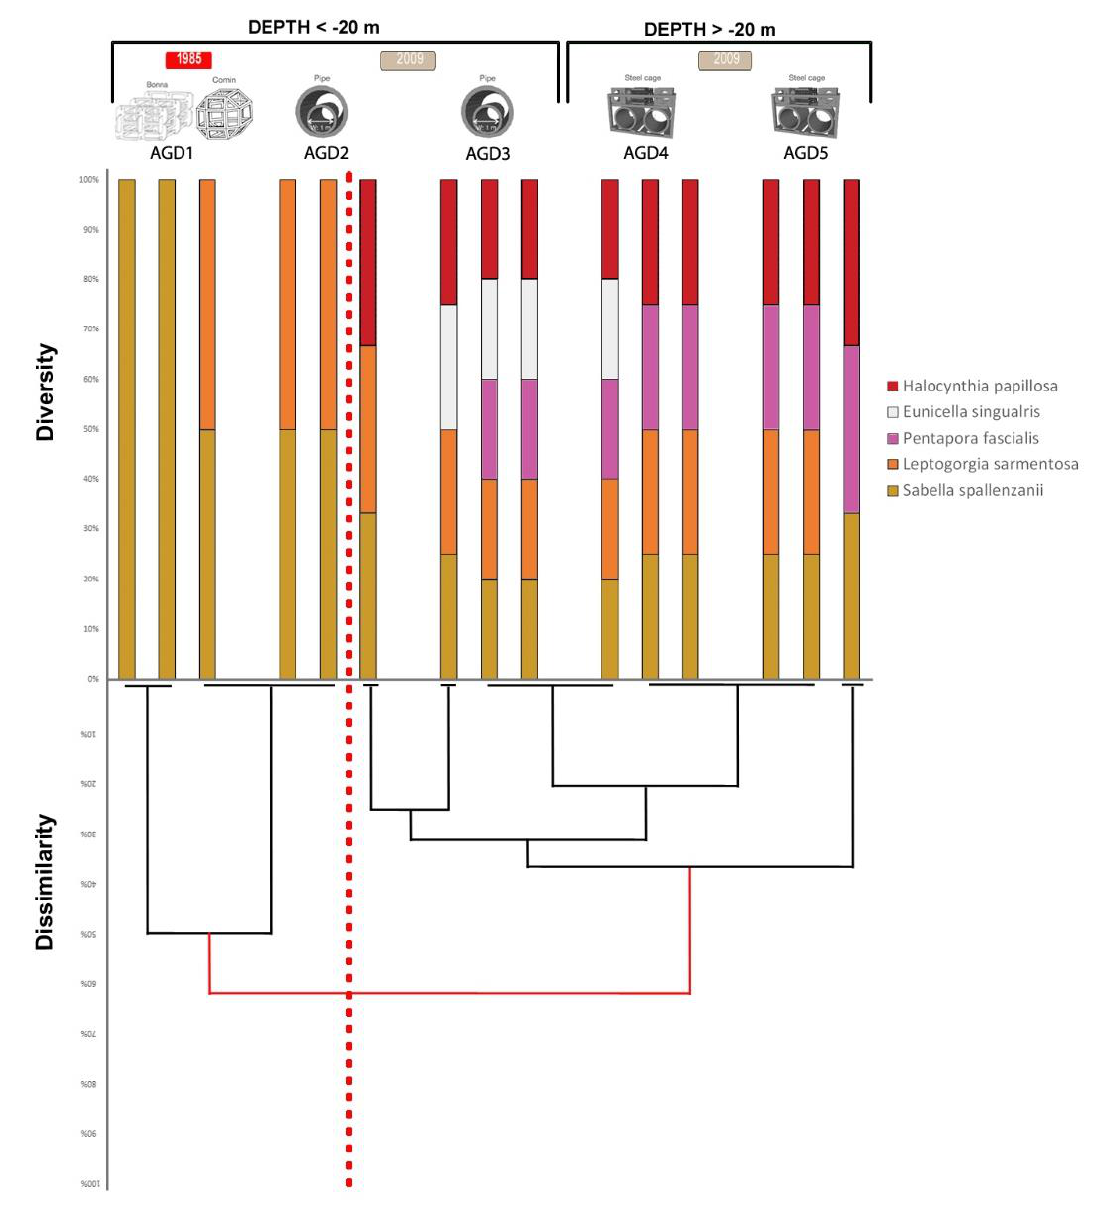
Figure 4: Diversity and dissimilarity. Upper part: diversity of species assemblages in the sampling units of the five sites (AGD1, AGD2, AGD3, AGD4, AGD5) in AGD sector together with the type of AR, depth and years of deployment. Lower part: dendrogram obtained by group average clustering based on the Jaccard dissimilarity index using the presence /absence of species (P=0.04 at 62% of dissimilarity). The red dotted line separates the two clusters identified by the